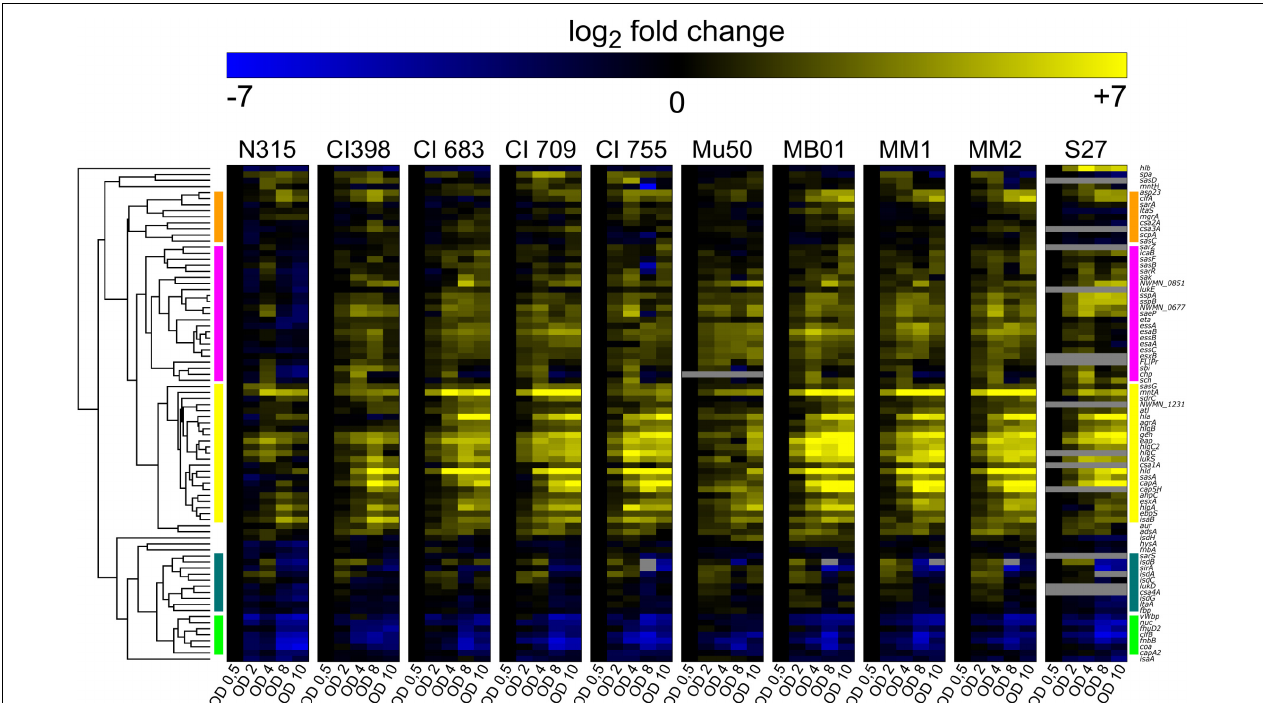
FIGURE 3 | Virulence factors transcript levels variation during in vitro growth curve. Each column represents one assay, while each row corresponds to a sample. Values are normalized to the first growth point (early stationary phase, OD 0.5). Genes transcribed at levels lower than the first growth point are depicted in blue, up-regulated genes are in yellow. The bars on the two sides of the heatmap represent the five major clusters: cluster1 (green), cluster 2 (dark green), cluster 3 (yellow), cluster 4 (pink), cluster 5 (orange). Several assays were not able to detect target transcripts in the S27 isolate. This might have been caused either by a high degree of mismatch between the probes and the target, or the absence of the target